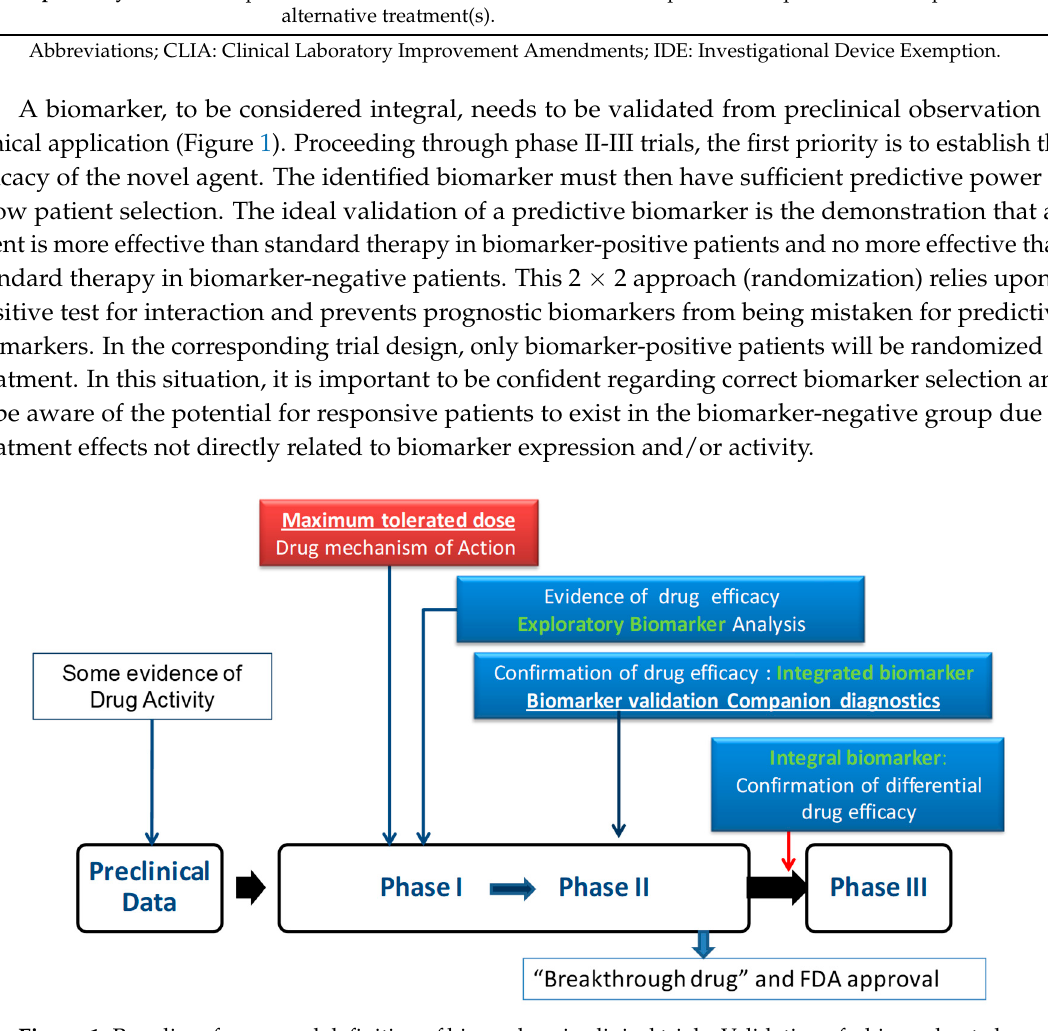
Table 2. Biomarkers definition.